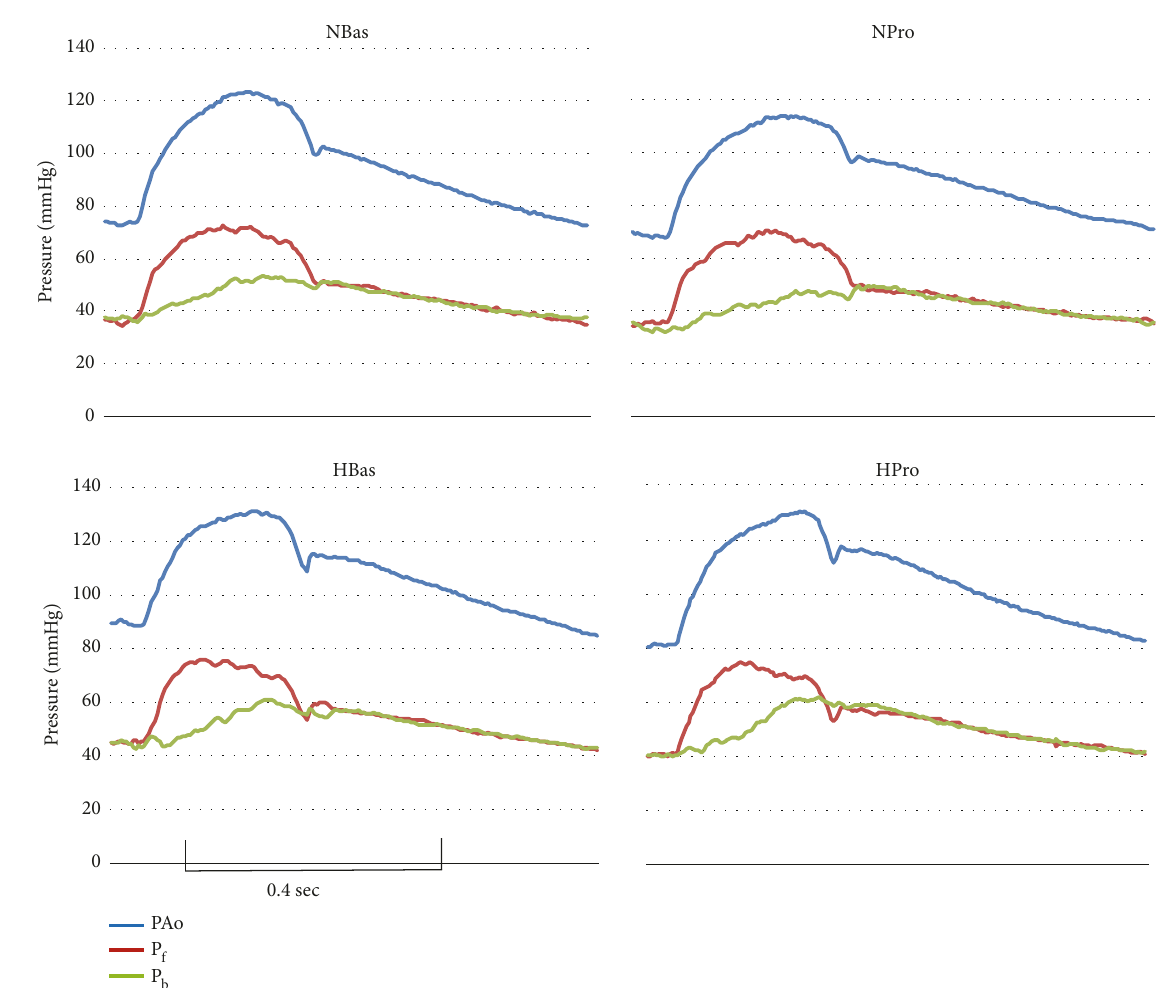
Figure 1: Representative plots of aortic pressure and its forward and backward components from one beat during baseline (Bas) and after propranolol (Pro) of one patient from the N subgroup and one from the P subgroup. The corresponding P f (mmHg), P b (mmHg), and P b /P f values for each beat are as follows: NBas: 37.9, 17.4, and 0.46; PBas: 34.0, 18.3, and 0.54; NPro: 36.3, 17.6, and 0.48; PPro: 34.7, 21.8, and